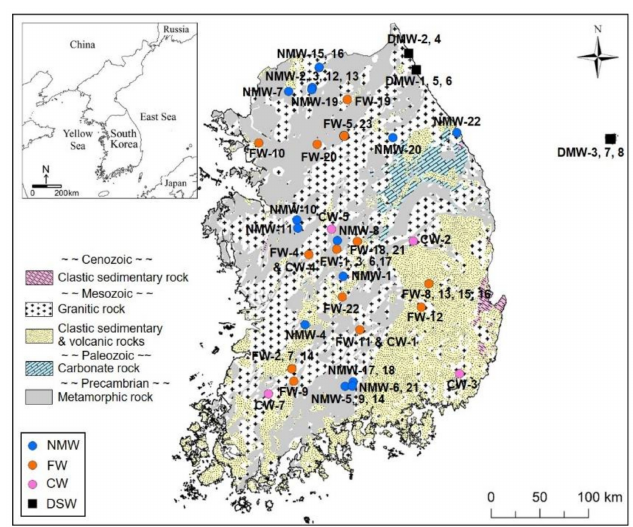
Figure 1. Geological map showing locations of groundwater used for bottled water. Korean bottled water mainly originates from groundwater underlying granitic and metamorphic rocks. NMW, FW, DSW and CW represent natural mineral water, functional water, desalinated sea water and carbonated water,